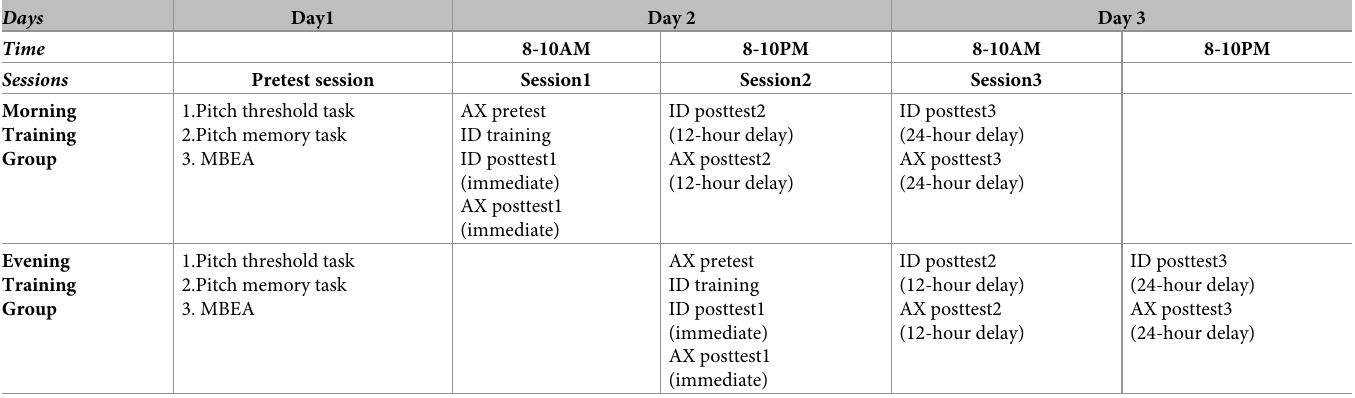
Table 2. Overview of timing in the experimental